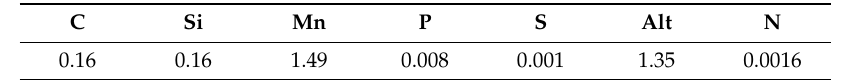
C Si Mn P S Alt N 0.16 0.16 1.49 0.008 0.001 1.35